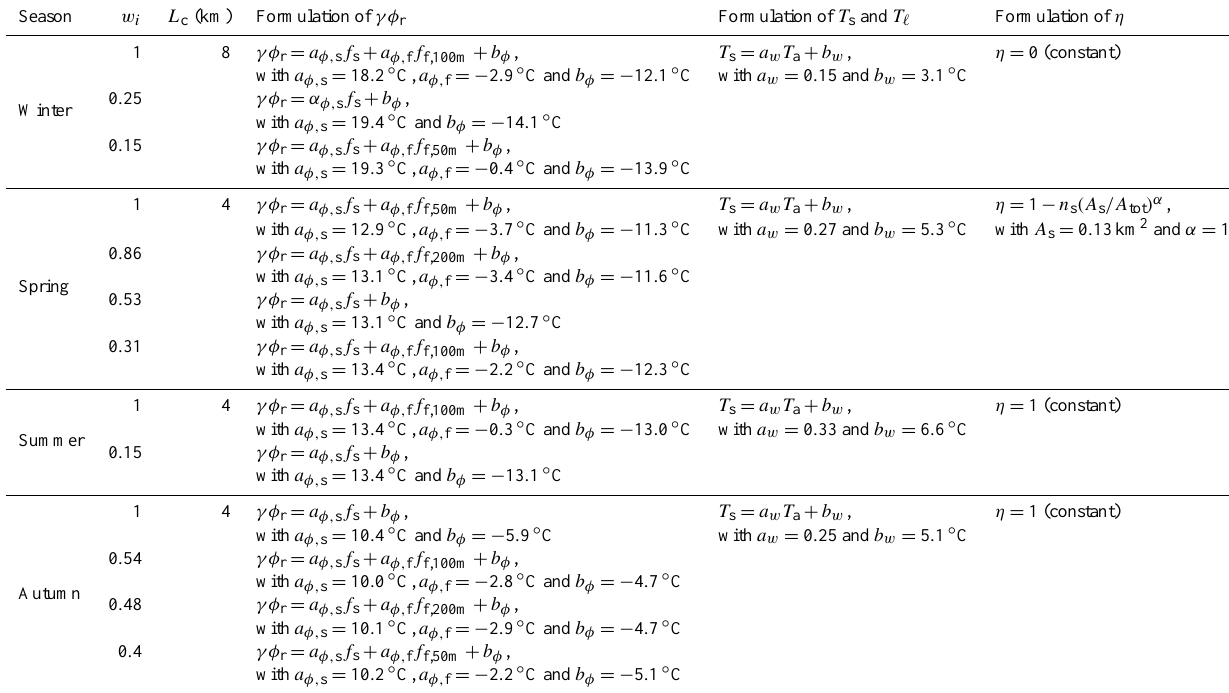
Table 4. Formulations of the physics-inspired statistical model selected in each season based on their corresponding AICc value. The Akaike weights are denoted as w i . Only the model formulations with w i ≥ 0 . 1 are presented here. The widths of the buffers used to compute the riparian vegetation cover are indicated as subscripts of the variable f f (the indicated values correspond to the total buffer widths, i.e. accounting for both sides of the stream centre